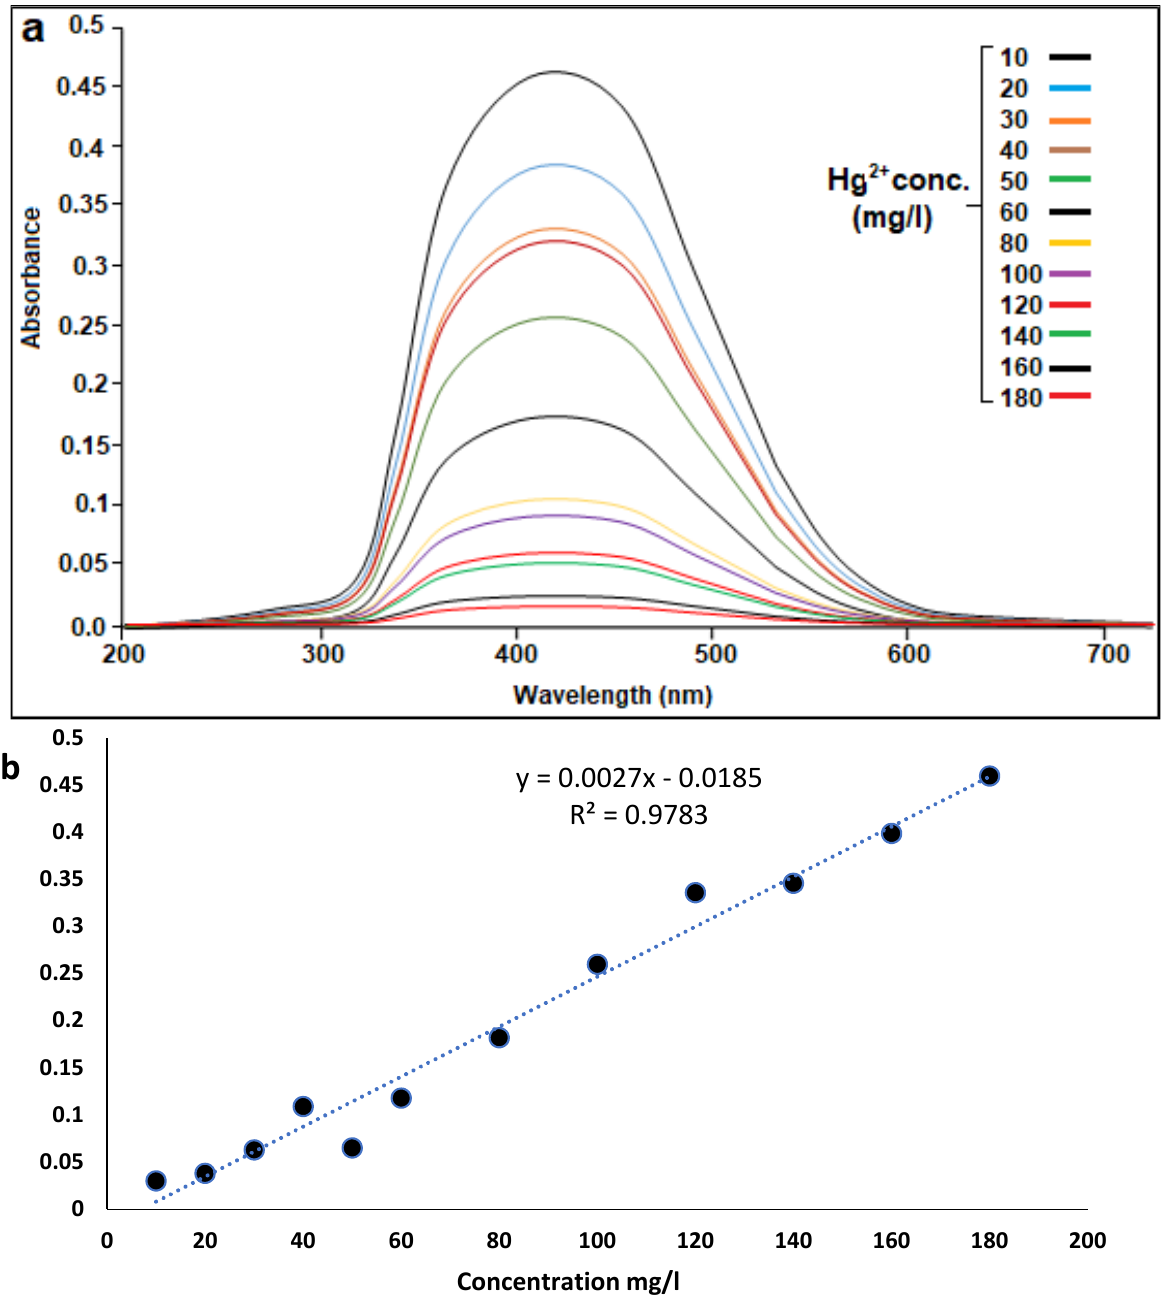
Figure 7. UV − Vis analysis ( a ) and calibration calculation ( b ) of AgNPs@AG performance validity at different concentrations (10–180 mg/L).